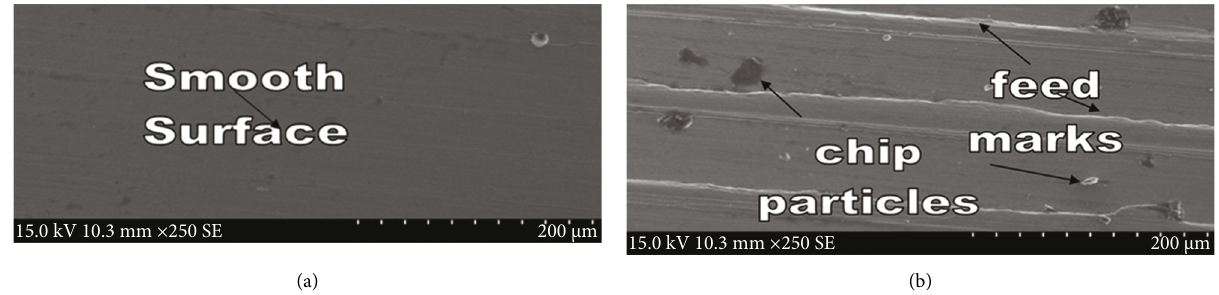
15.0 kV 10.3 mm ×250 SE